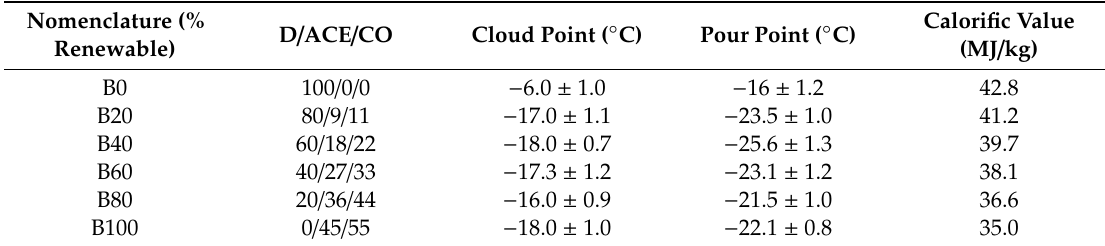
Table 3. Cloud point, pour point, and calorific value of diesel / acetone / castor oil blends, obtained by adding di ff erent amounts of fossil diesel to acetone / castor oil double mixture, containing 45% acetone. Errors are always calculated from the average of three